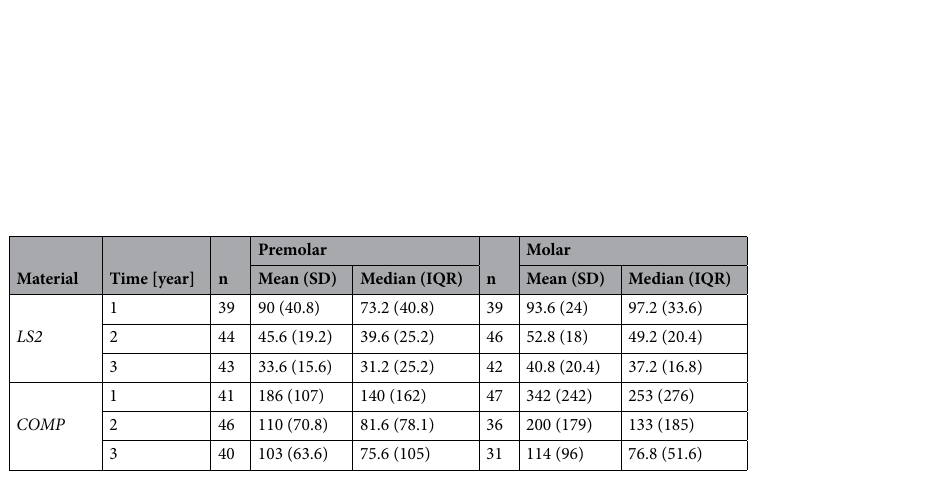
Table 2. Mean values ± standard deviation (µm/month) of wear rates of premolar and molar restorations for individual patient, respectively.